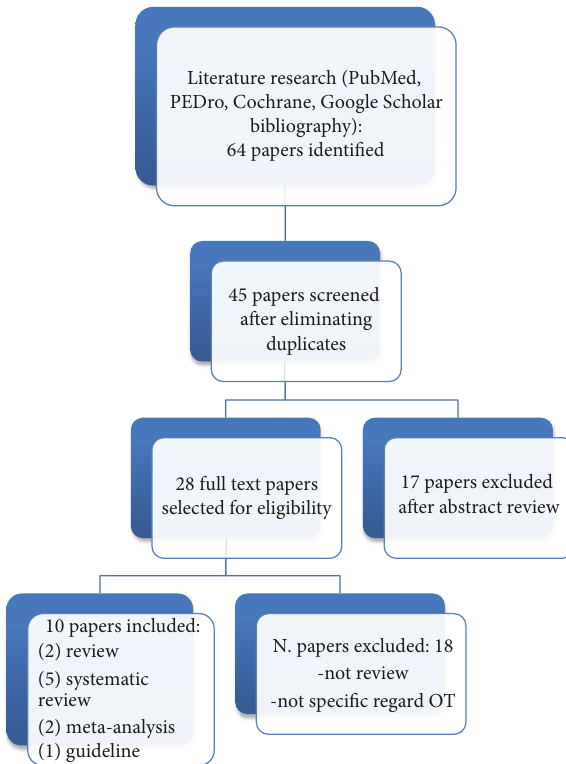
Figure 1: Flow chart that shows selection